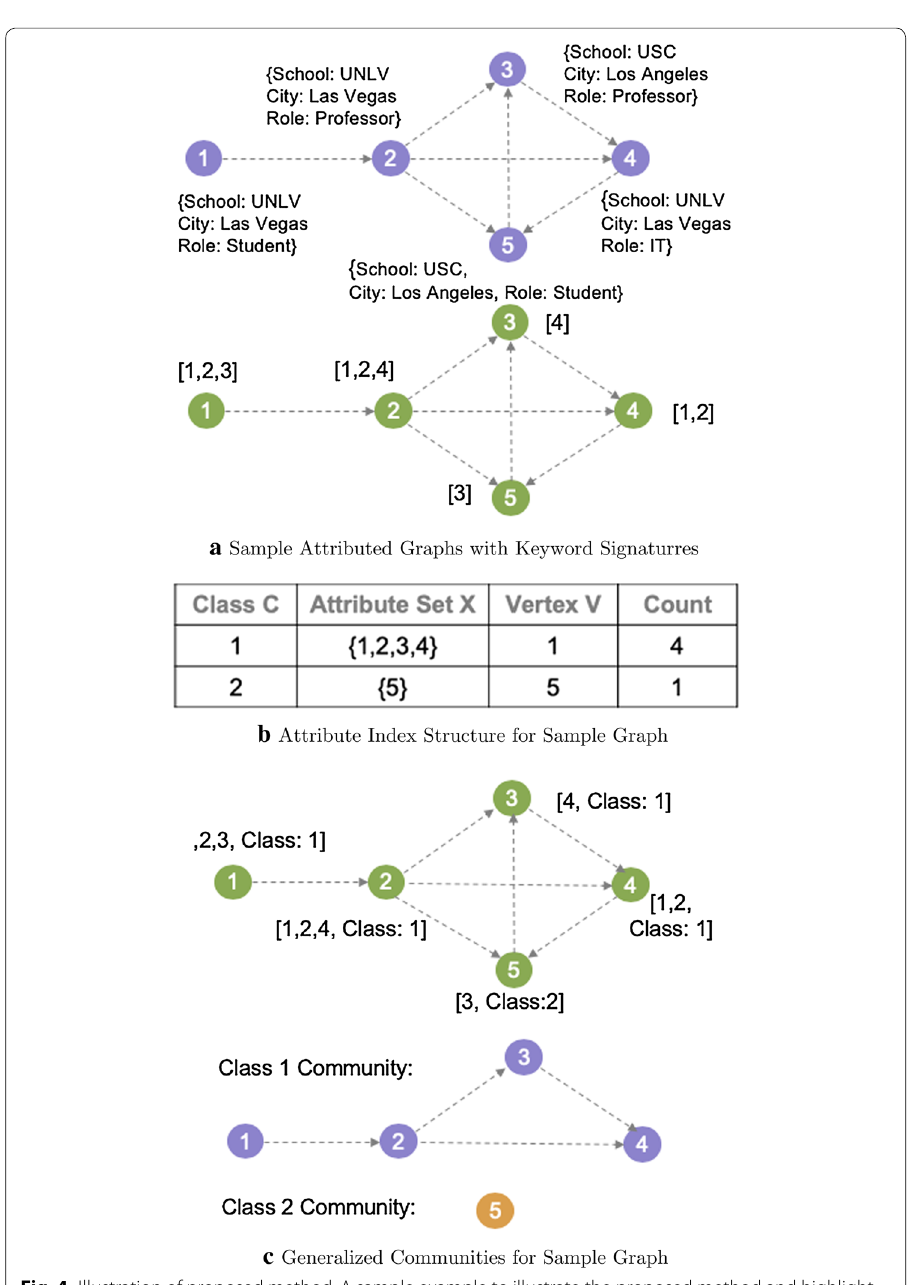
Fig. 4 Illustration of proposed method. A sample example to illustrate the proposed method and highlight important steps of the proposed